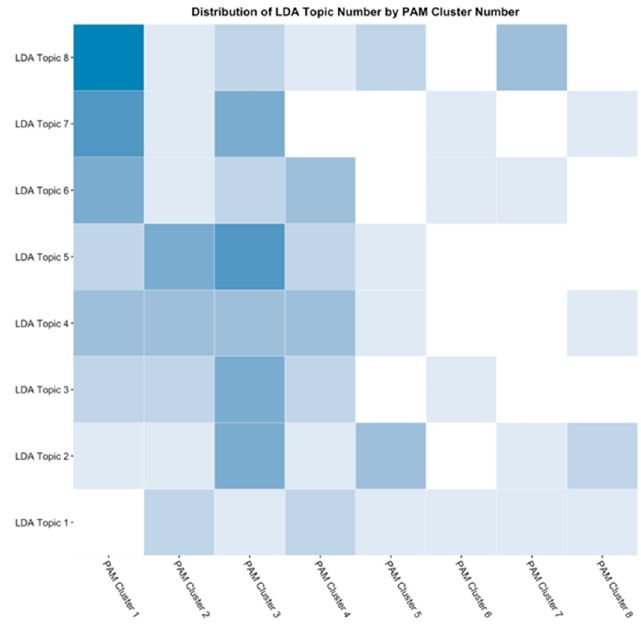
Figure 19. Plot demonstrating the distribution of each of the LDA topics amongst the different partitioning around medoids clusters.